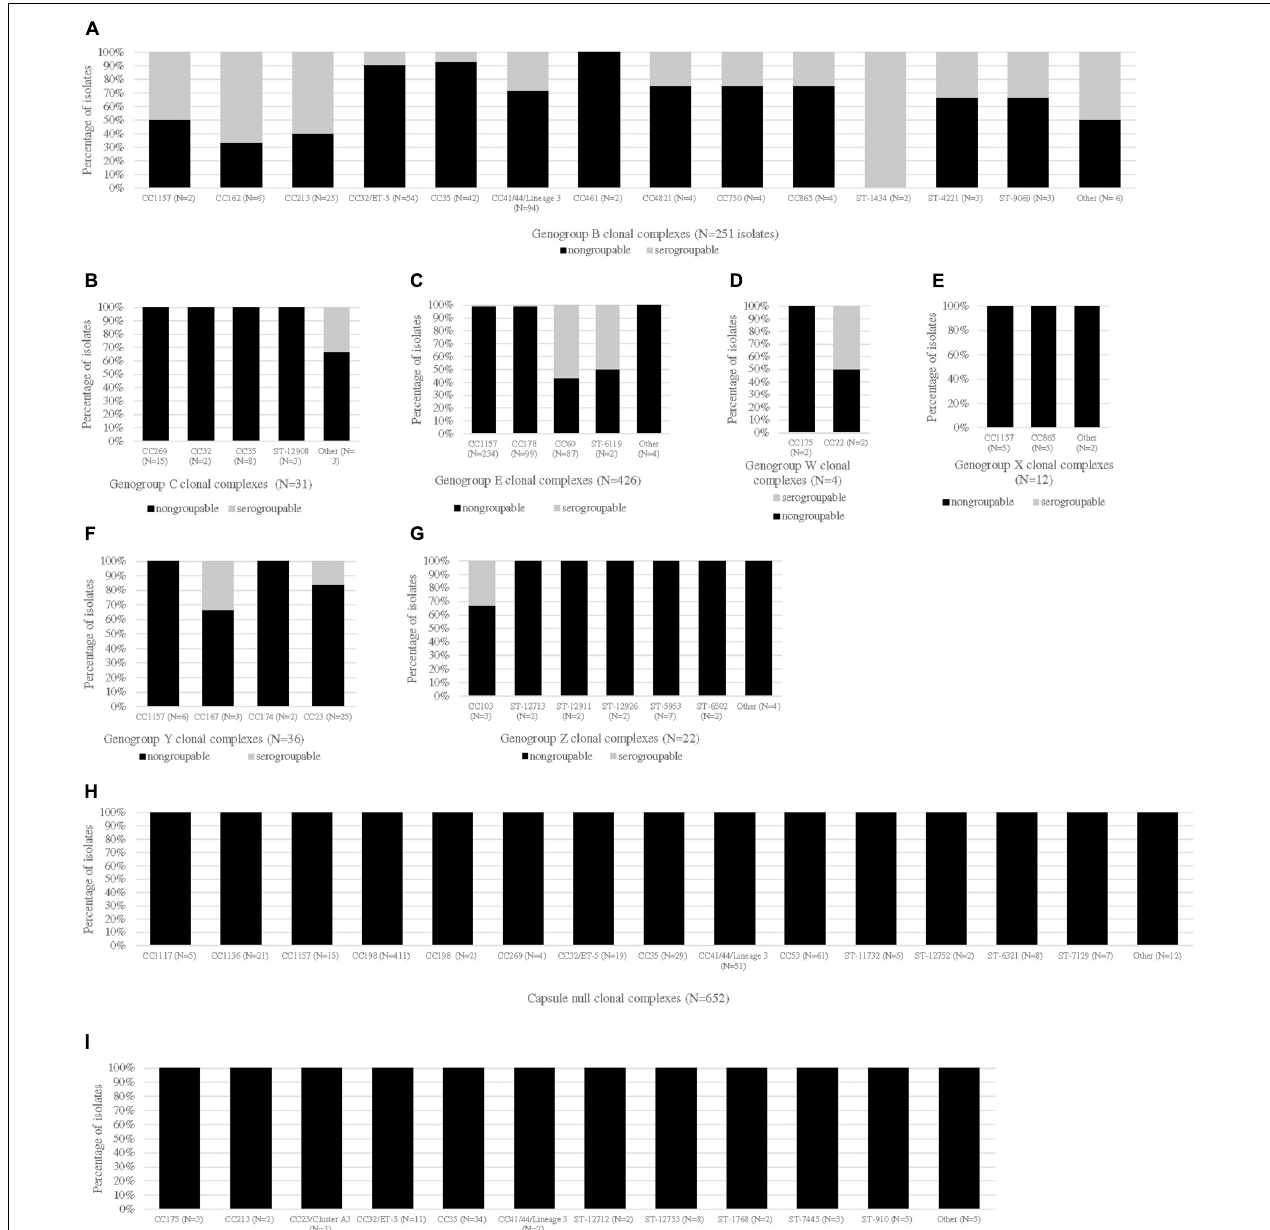
FIGURE 1 | CC distribution of Nm carriage isolates by genogroup and serogroup. The proportions of serogroupable (shown in gray) and non-serogroupable (shown in black) meningococcal isolates were presented for each genogroup-specific clonal complex (CC): genogroup B (A) , genogroup C (B) , genogroup E (C) , genogroup W (D) , genogroup X (E) , genogroup Y (F) , genogroup Z (G) , capsule null (H) , and non-groupable undetermined genogroup (I) . If a CC was unassigned, the sequence type (ST) was provided. The “other” category represents the genogroup-specific CCs that contained only one isolate. The serogroupable